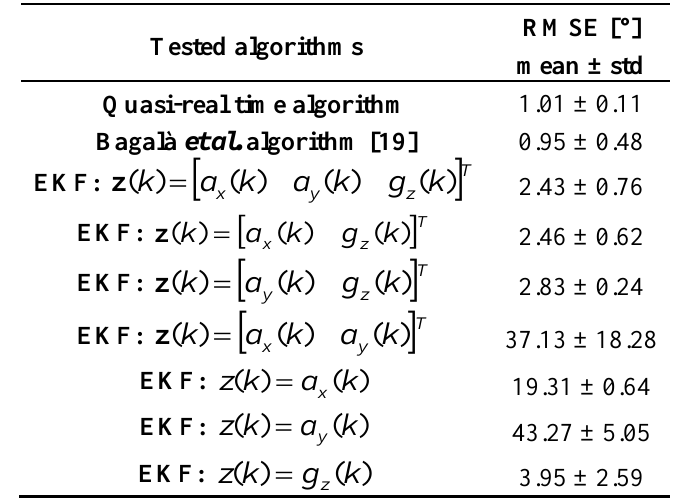
Table 2. Averaged RMSEs for the knee flex-extension angle.